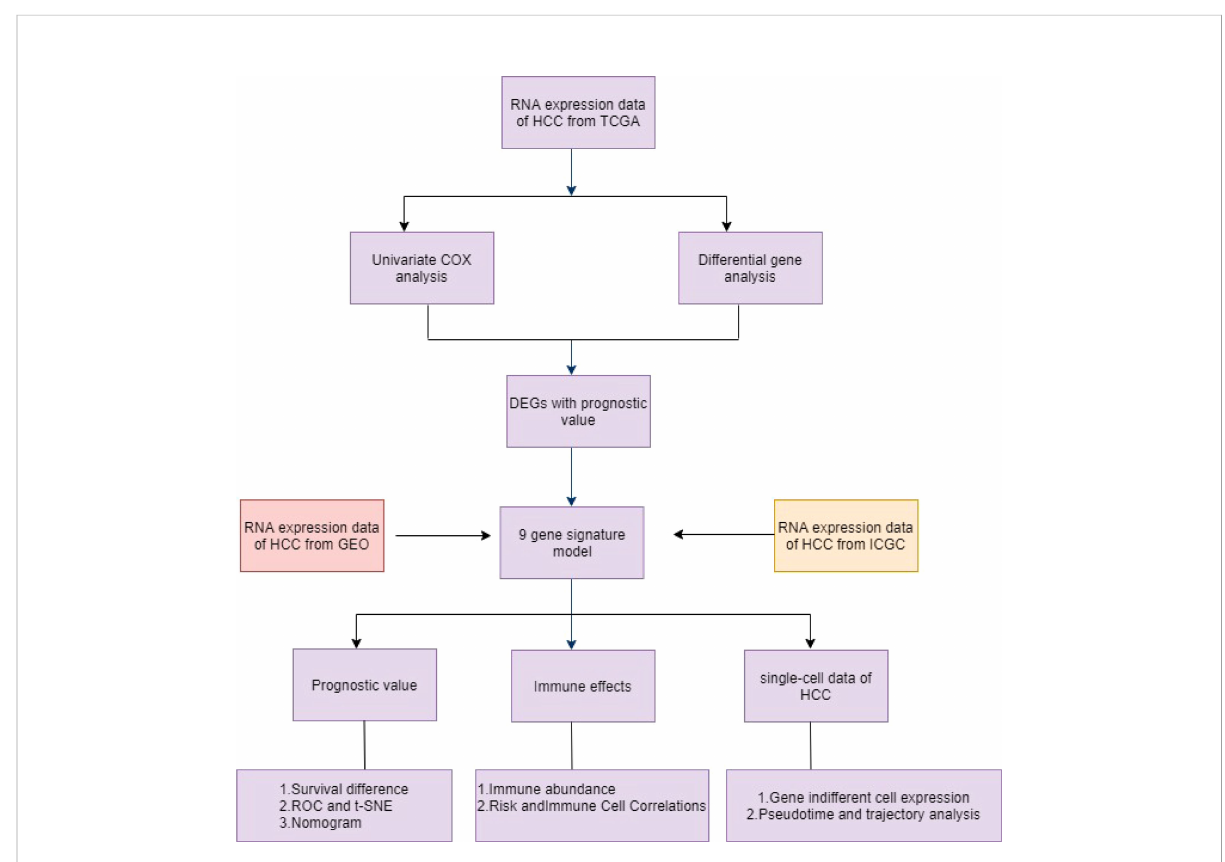
FIGURE 1 Schematic diagram of the overall design of the